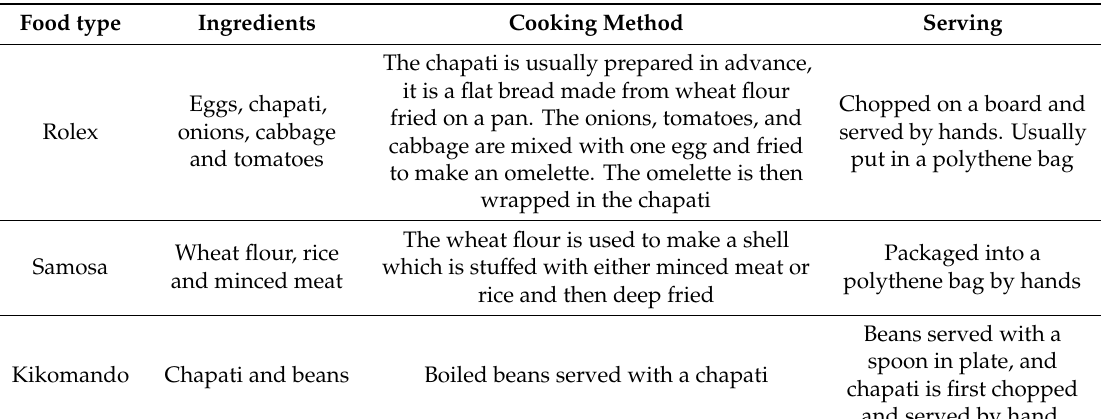
Table 4. Street food type and its